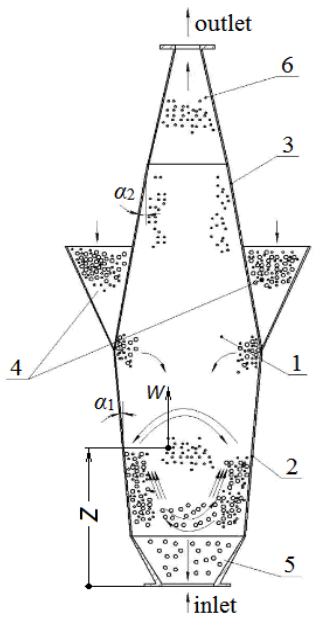
Figure 1. Design scheme of the pneumatic classification process.